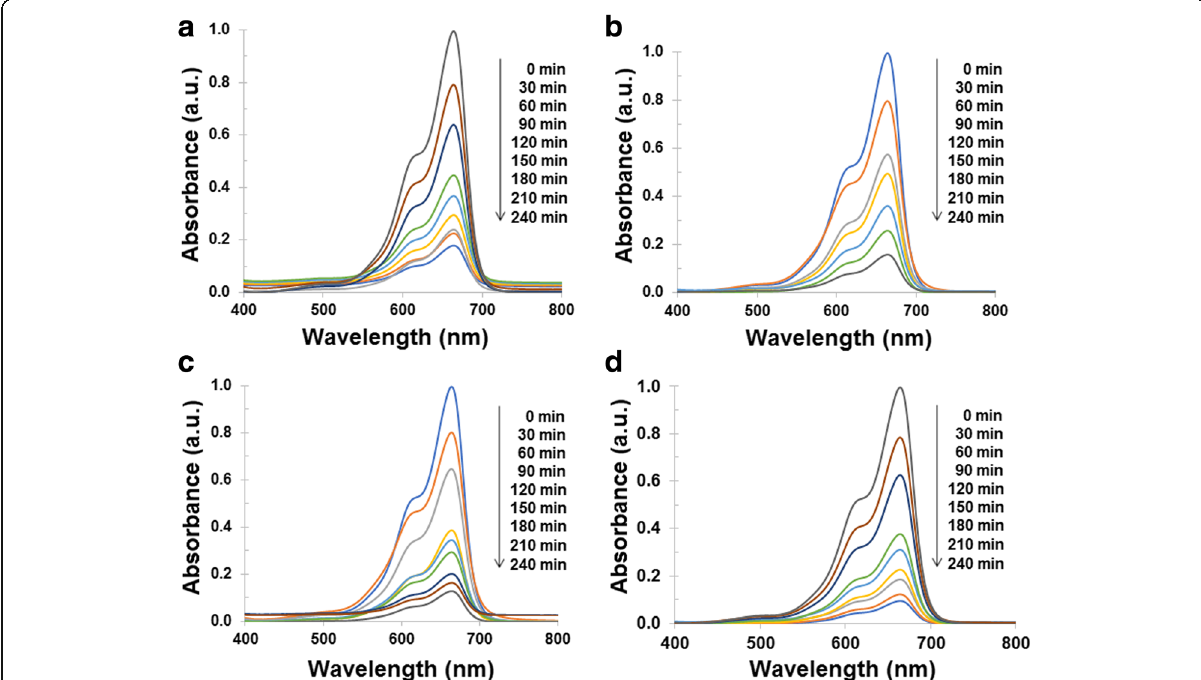
Fig. 9 UV-visible spectra of MB solution using a Sb 2 S 3 , b 0.1 HEC-Sb 2 S 3 , c 0.2 HEC-Sb 2 S 3 , and d 0.3 HEC-Sb 2 S 3 as photocatalytic